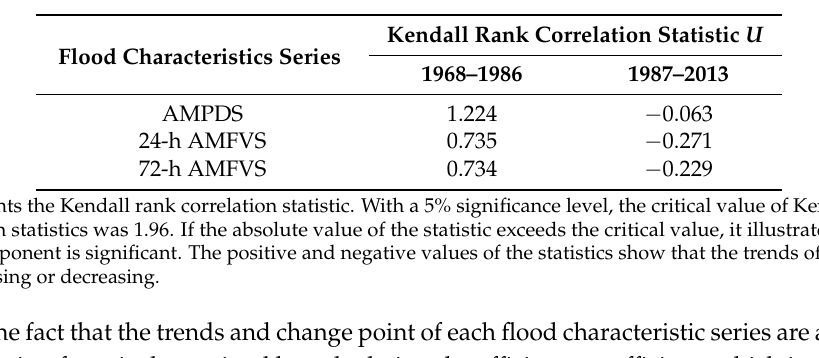
Table 5. Kendall rank correlation statistic values for the flood series before and after the change